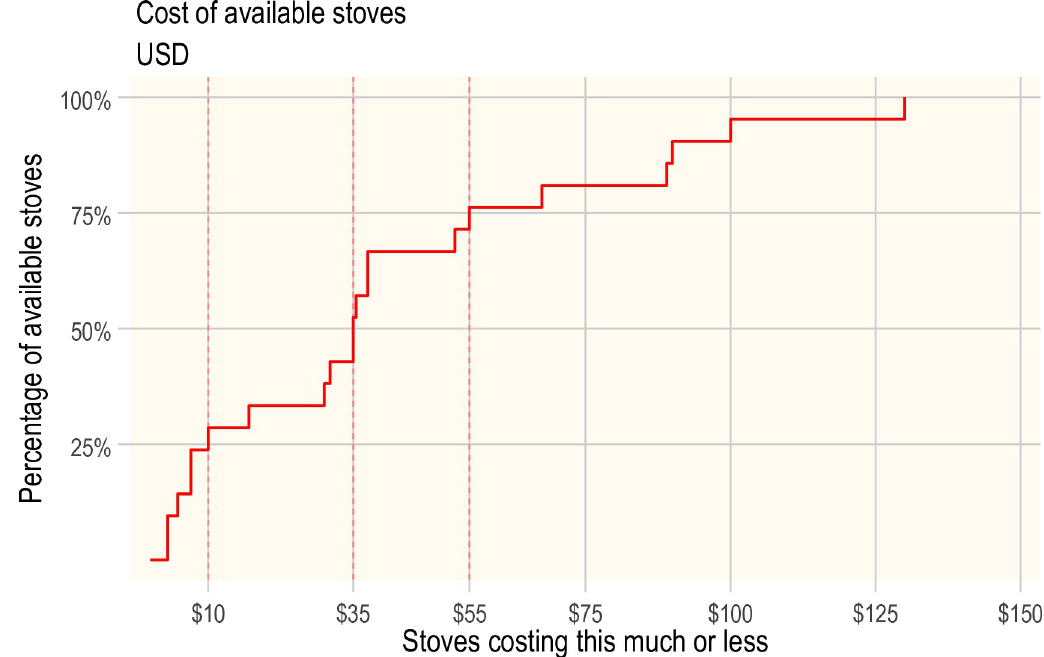
Fig 4. The cummulative distribution chart of the stepped rises in the number of cookstoves (n = 21) available at or below the given cost.